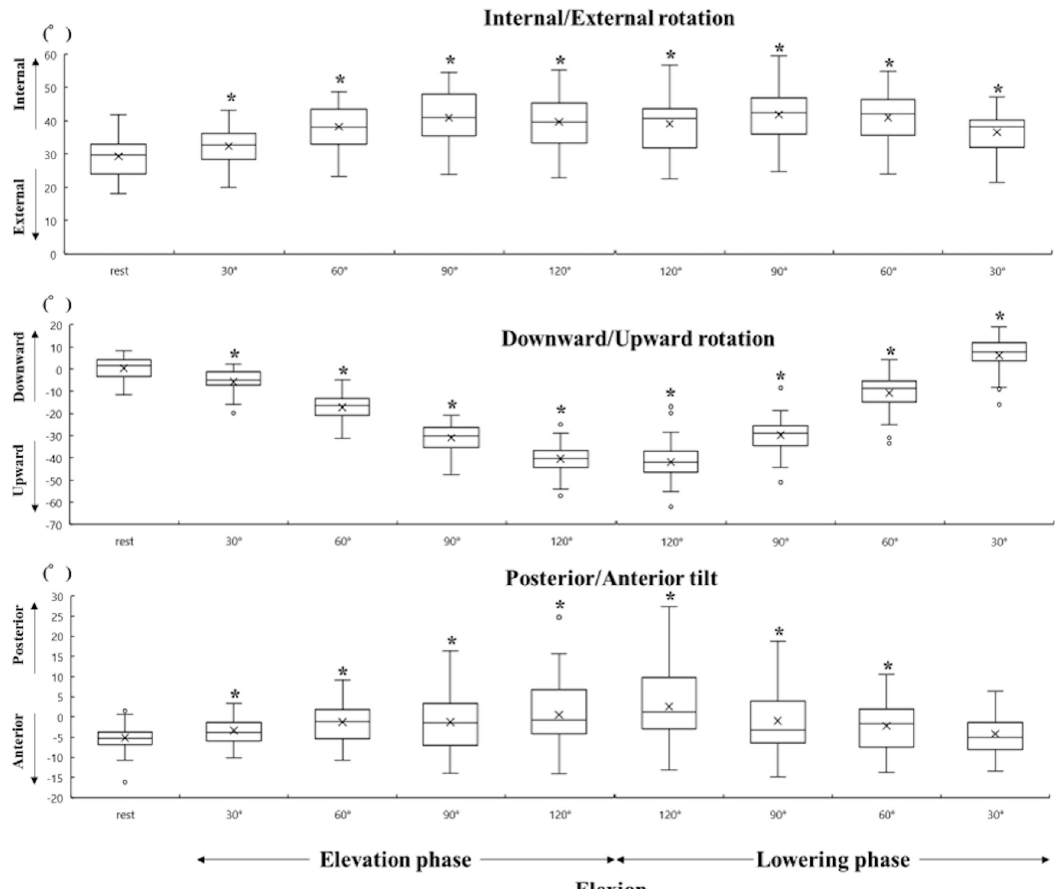
Fig 3. Scapular position and movement during flexion. Box-and-whisker plots show internal and external rotation (top), downward and upward rotation (middle), and anterior and posterior tilt (bottom) of the scapula. The X-axis is the humeral angle and the Y-axis is the scapular angle. The asterisk represents the significant difference compared with the scapular position at rest (P < 0.05).